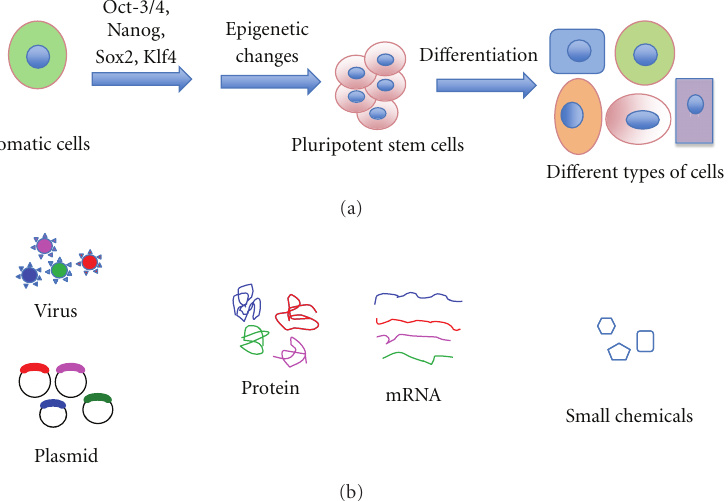
Figure 1: A simplified version of reprogramming of adult cells to pluripotent cells by 4 factors. (a) Any adult source of cells like epithelial, muscle, fibroblast, and adipose cells is isolated and cultured in appropriate medium. Then cells are transfected, nucleofected, or transduced by 4 reprogramming factors. These factors may be Oct3/4, Sox2, Nanog, and Klf4/c-Myc. The reprogramming paths are not well understood yet, requiring expression of several genes as well as epigenetic modification of the genome. (b) Reprogramming factors (transcription factor genes) can be delivered by various methods. In case of viral gene delivery, genes are integrated with the host chromosome randomly. Methods of gene deliveries like plasmids, mRNAs, proteins, genes are expressed transiently and diminished the expression with the concomitant increase in expression of pluripotent